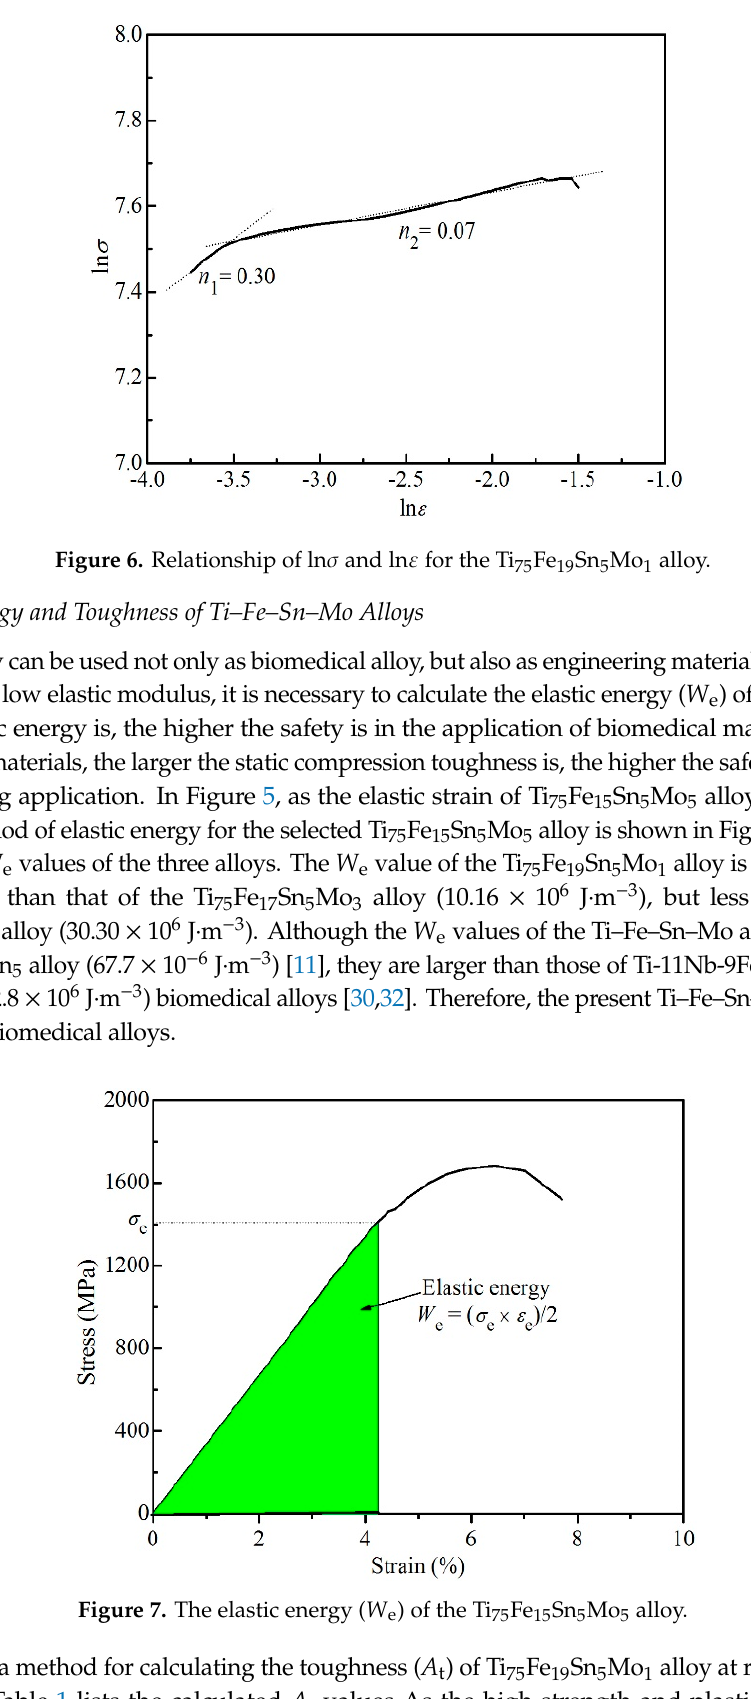
75 Fe 19 Sn 5 Mo 1 alloy.